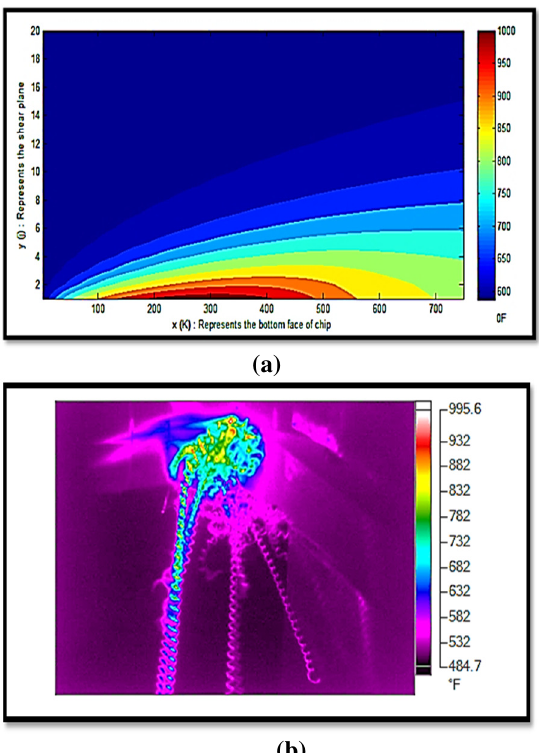
Fig. 16. Temperature fields of machining with spindle speed (400 r.p.m), feed (0.12 mm/rev), depth (0.5 mm), (a) temperature distribution simulation, (b) experimental measuring of temperature using IR-Camera.